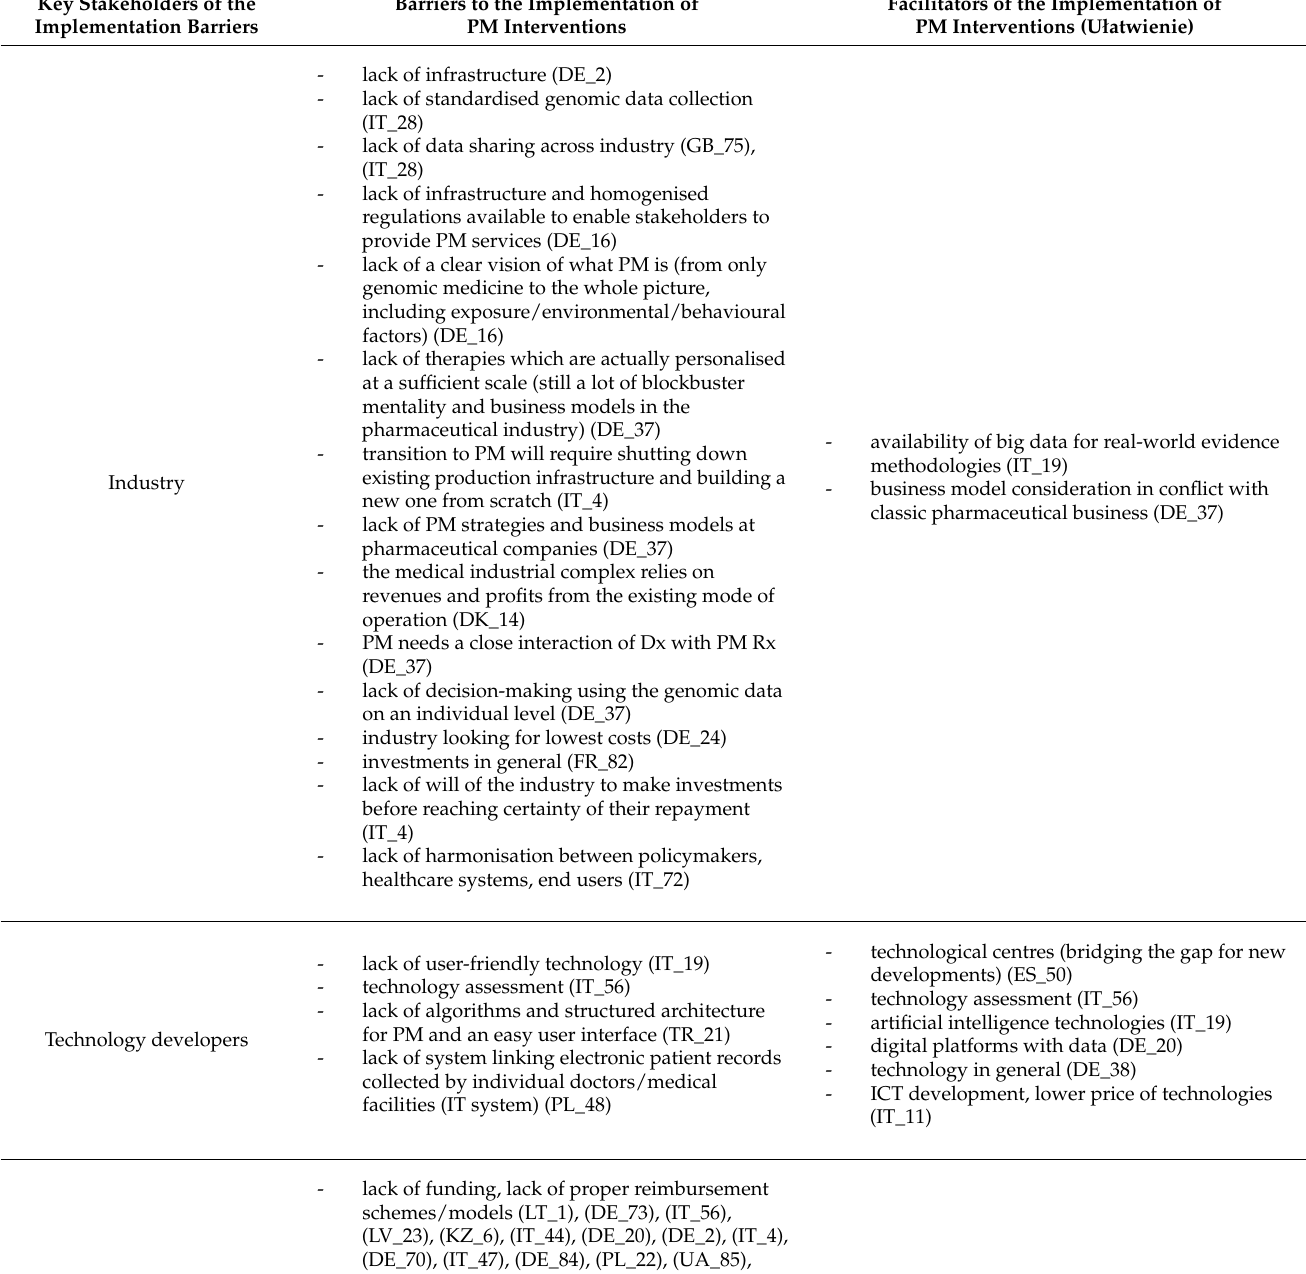
Facilitators of the Implementation of PM Interventions